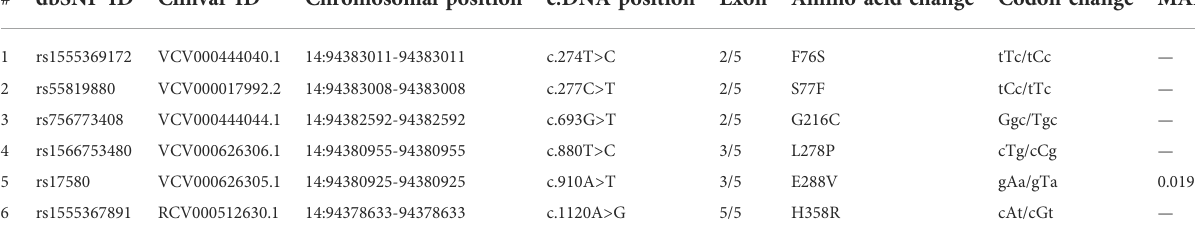
TABLE 1 Molecular details of alpha-1-antitrypsin causative SERPINA1 missense